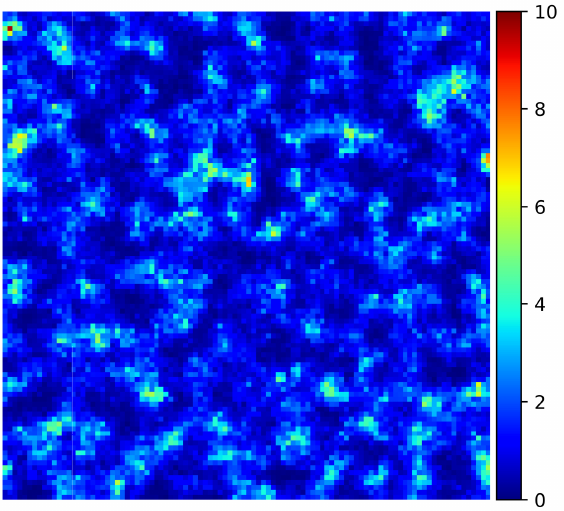
Figure 1. An illustrative example of the stochastically simulated artificial images. The radius R , the shape parameter α , and the scale parameter λ are 6 pixels, 16 , and 3 , respectively. 9 4 Figure 2. An illustrative example of the spatially oversampled images. Equation (11) is adopted for the resampling. ¨ σ 2 is set to age as the final pixel value. Furthermore, since the noise level 1 for the simulated noises. Two pixels are missing from each of an oversampled image is controlled by the constant ¨ σ , the 2 side of the image due to the application of Equation ratio of the variance αλ 2 of the Gamma distribution used for generating the corresponding artificial image to ¨ σ 2 is defined as the signal-to-noise ratio of the oversampled image in this study.